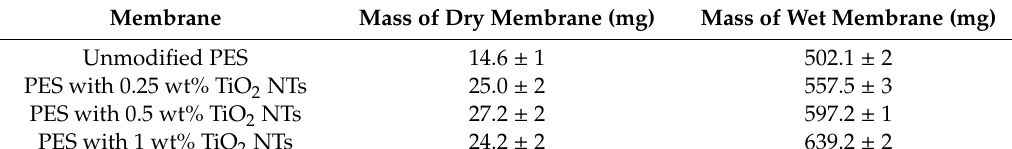
Table 2. Measured masses of dry and wet membranes for porosity and mean pore radius.